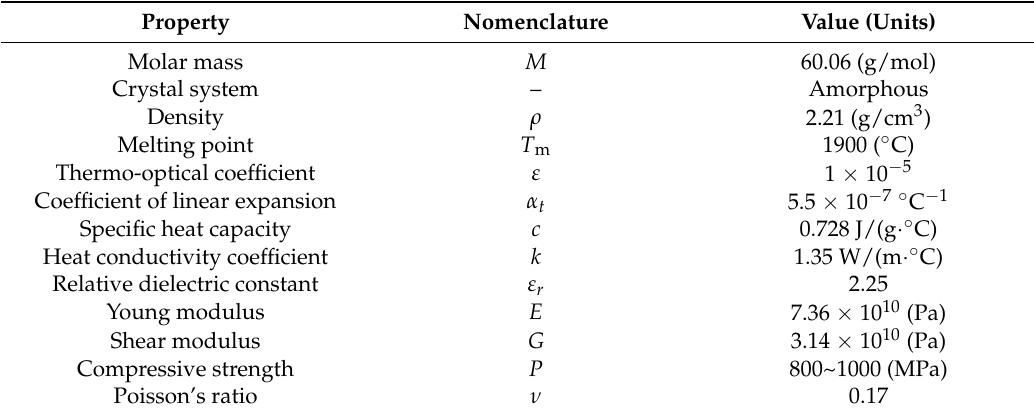
Table 1. Thermodynamic parameters of fused silica materials used in calculations [39,40].